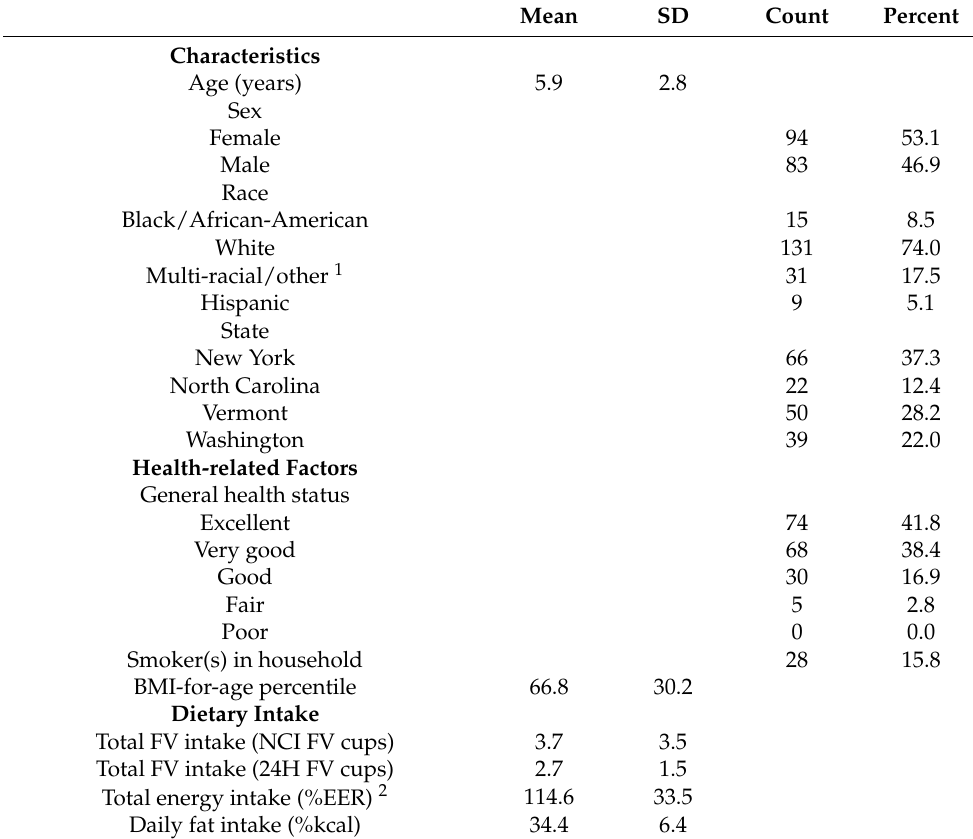
Table 1. Characteristics of children enrolled in a healthy eating intervention trial in four U.S. states ( n =